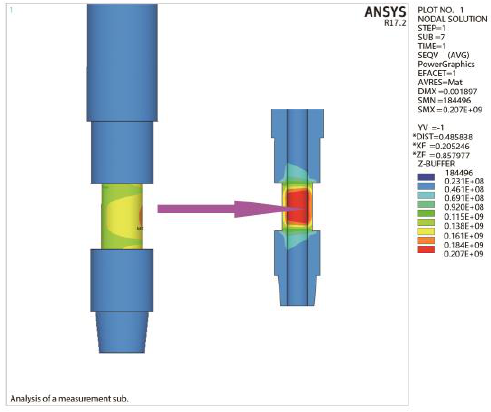
Figure 13. Stress distribution of elastic cell under extreme measurement condition.